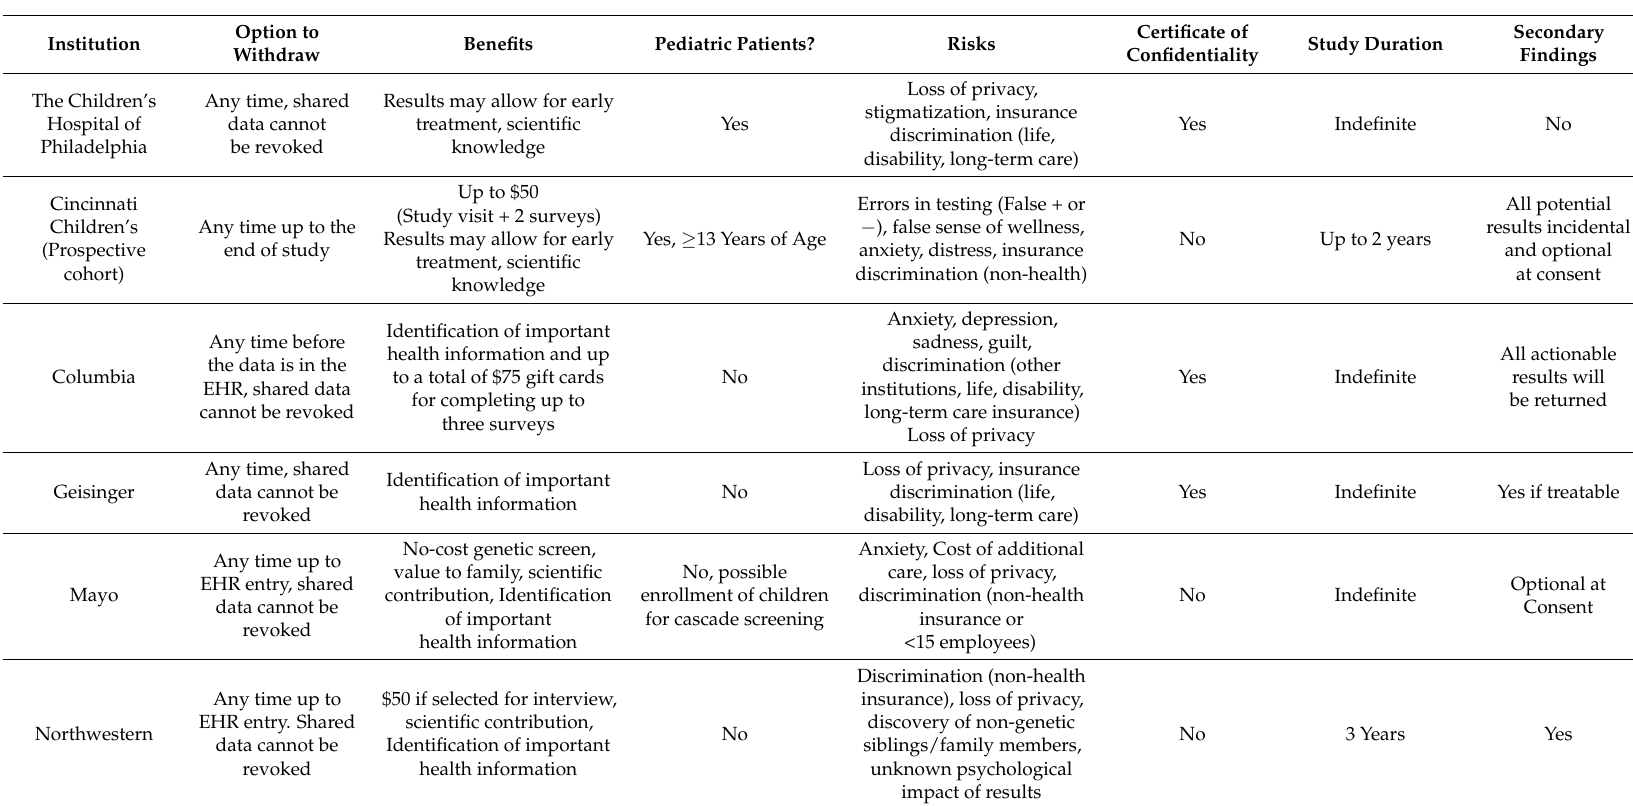
Table 2. A summary of the content of consent forms from each eMERGE